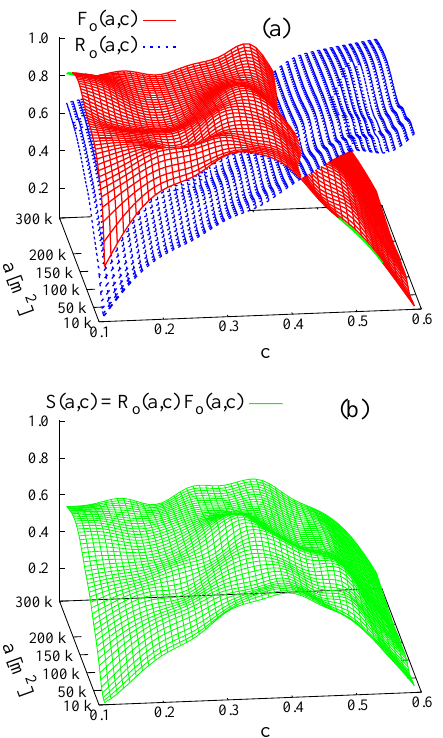
Figure 13. (a) R o (a,c) (blue) and F o (a,c) (red) functions, defined by Eqs. (9) and (10). (b) S o (a,c) function defined by Eq. (11). The functions were interpolated on a denser mesh for improved visual representation. Figure 14. The SU subdivision corresponding to the best parame-